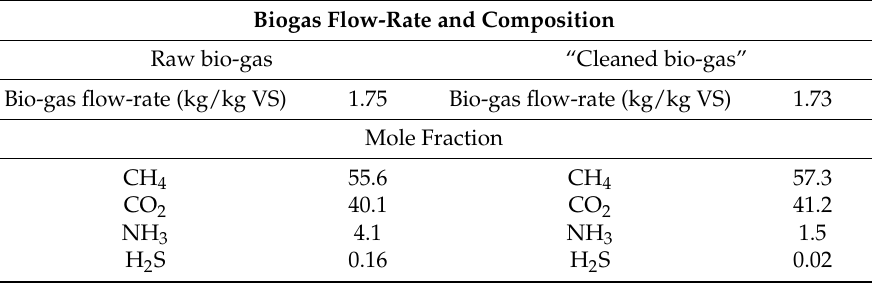
Table 2. Biogas flowrate and mole fractions for main components.